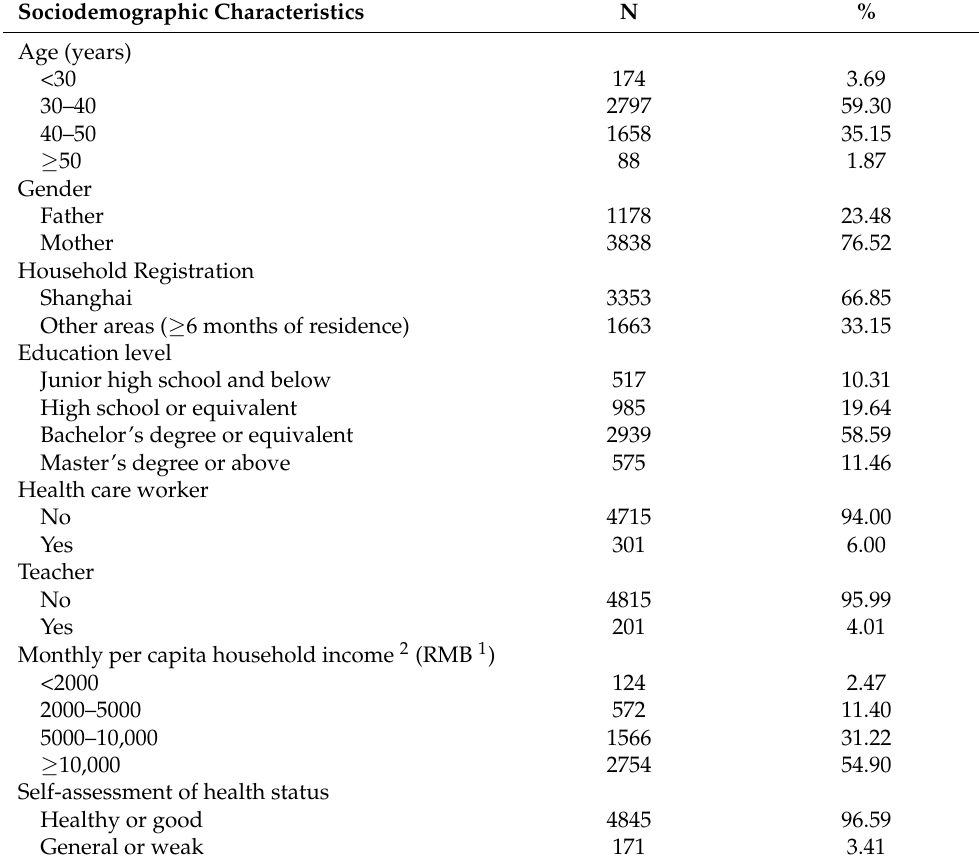
Figure 1. Flow chart of parent questionnaire inclusion. Table 1. Sociodemographic information of the study subjects (N = 5016).